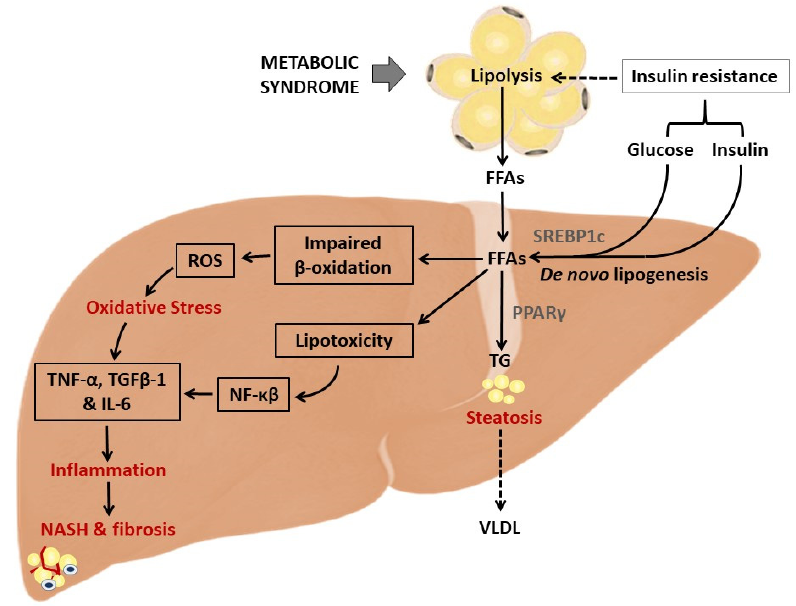
Figure 2. An overview of the pathophysiological mechanisms that implicate oxidative stress and inflammation in the development and worsening of non-alcoholic fatty liver disease (NAFLD). Briefly, in an obese state, adipose tissue can promote excess glycerol release and free fatty acid (FFA) flux that saturates the liver at rates that exceed the capacity of mitochondrial β -oxidation, leading to the activation of transcriptional factors like peroxisome proliferator-activated receptor gamma (PPAR γ ). In an aggravated state, this process promotes the increased production of reactive oxygen species (ROS) and aberrant levels of pro-inflammation markers such as tumour necrosis factor alpha (TNF- α ), the nuclear factor kappa-light-chain-enhancer of activated B cells (NF- κ B), and transforming growth factor beta (TGF β )-1, which are linked with the development of steatosis. ROS = reactive oxygen species; TG = triglycerides; SREBP1c = sterol regulatory element binding protein; NASH = non-alcoholic steatohepatitis; IL-6 = interleukin 6; VLDL = very low density lipoproteins.